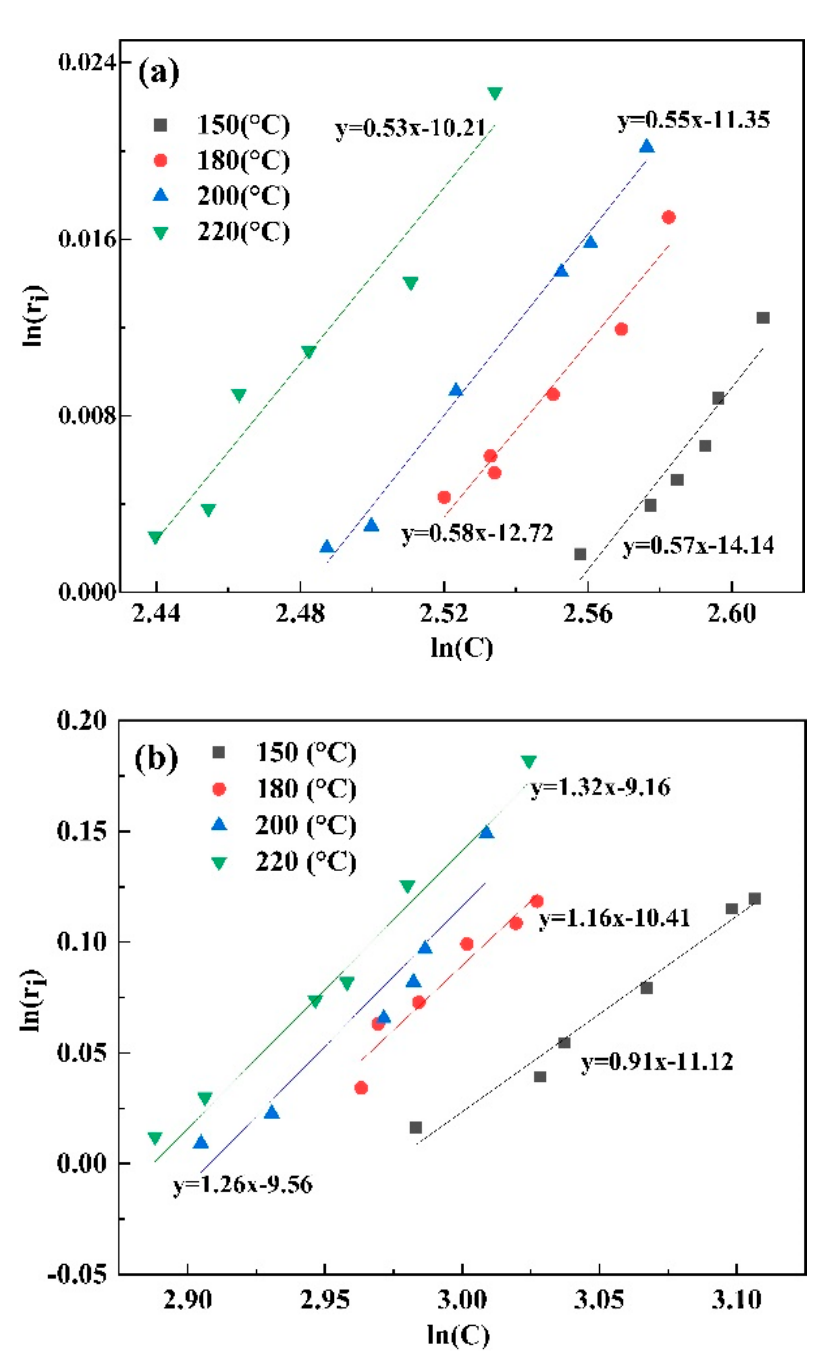
Figure 9. Fitting results of Equation (7) at different temperature: ( a ) Na 2 SO 4 ; ( b ) K 2 SO 4 . Finally, according to the relationship between the reaction rate constant (k) and tem- perature (T), the apparent activation energy E a of natroalunite and alunite were calculated using the Arrhenius formula (see Equation (8)) [28–30], as shown in Figure 10. ln k = − E (cid:2911) RT + A where k is the reaction rate constant, E a is the apparent activation energy (kJ/mol), R is the molar gas constant (J · mol − 1 · K − 1 ), T is the reaction temperature (K), and A is the constant.